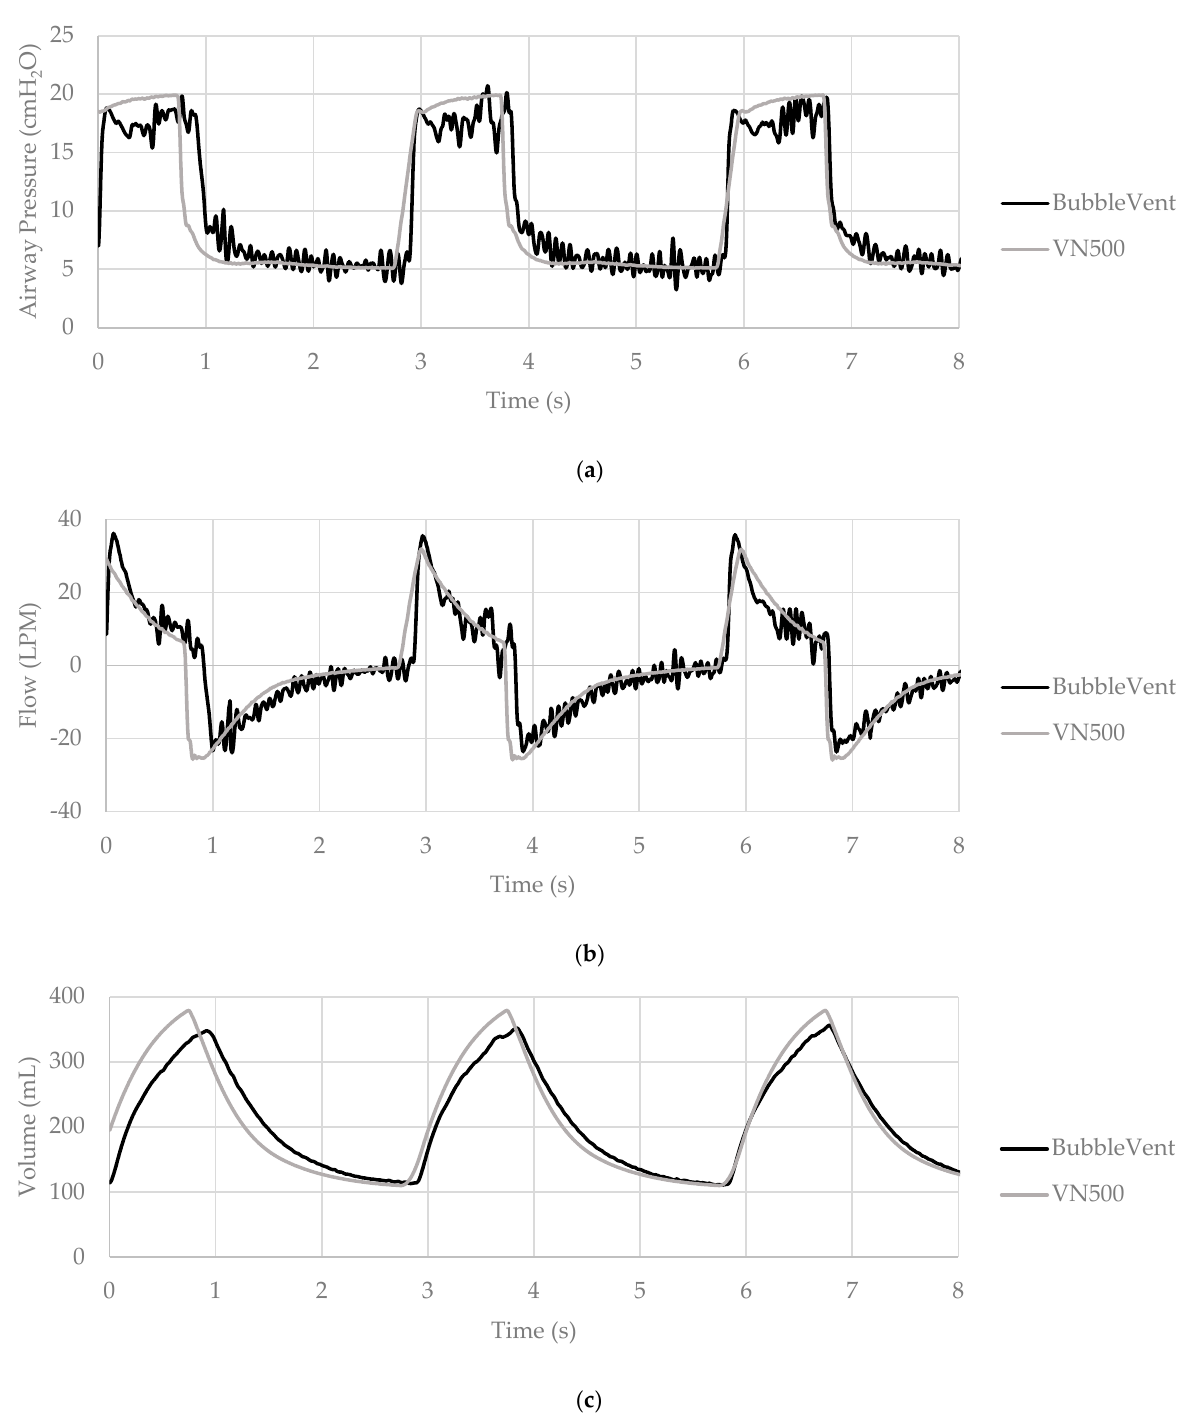
Figure 5. Waveform tracings of the BubbleVent and Draeger VN500 for three breaths. Lung model compliance and resistance was set to 20 mL/hPa and 20 hPa/L/s, PIP to 20 cmH 2 O, and PEEP to 5 cmH 2 O; RR = 20 BPM and T I = 1.0 s. Figure ( a ) is airway pressure, ( b ) is inspiratory flow, and ( c ) is volume.